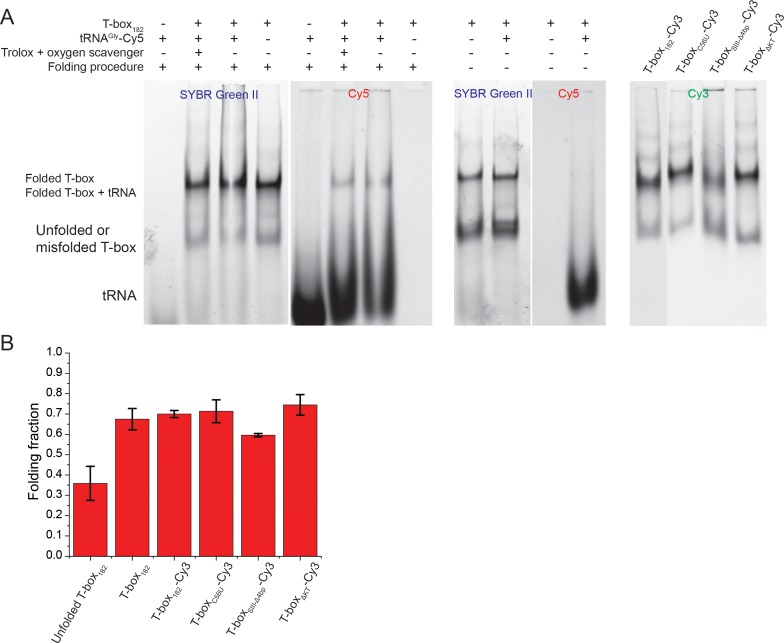
Native gel electrophoresis analysis of the folding of T-box constructs and binding of tRNA.(A) T-box constructs and tRNA were refolded as described in the Materials and methods. Folding of tRNA is close to 100%, whereas a fraction of T-box is not folded in each construct. However, tRNA-Cy5 only binds to the correctly folded fraction; therefore, the residual unfolded or misfolded fraction does not interfere with our smFRET data collection or analysis. In addition, adding an oxygen scavenger and triplet-state quencher does not interfere with the binding of tRNA-Cy5. All T-box mutants show comparable folding efficiency as the wild-type T-box182. (B) Quantification of the folding efficiency was performed by ImageJ (Schneider et al., 2012) with background subtraction. Error bars represent standard deviation from at least three independent experiments.